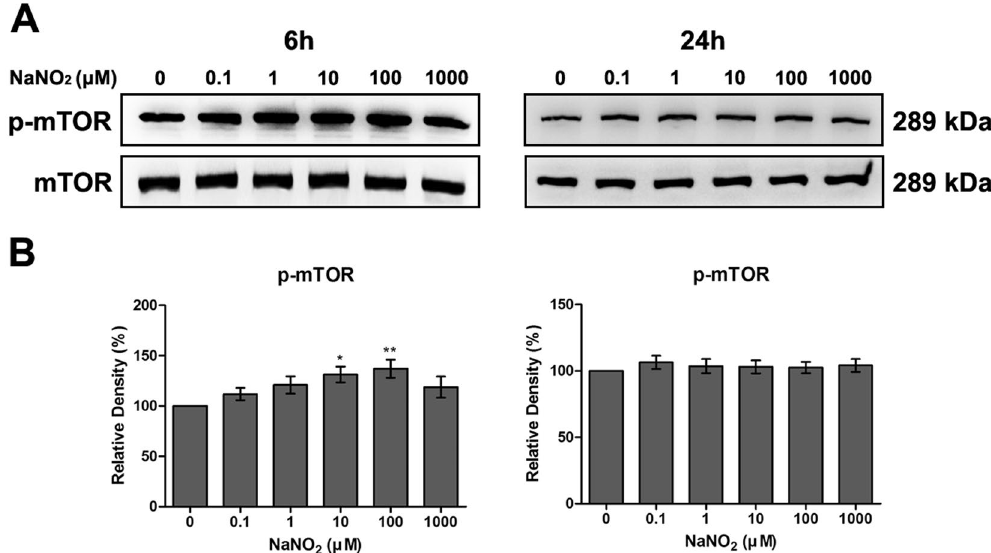
Figure 4. Effect of NO on mTOR pathway of HCEC. Expression levels of phosphorylated mTOR (p-mTOR) and mTOR, detected by western blot analysis ( A ) and relative densitometry ( B ), were calculated as a percentage of the control. Increased phosphorylation of mTOR was observed at 6 h exposure to 10 μ M and 100 μ M of NaNO 2 . Full size images of blots are available in the Supplementary information. Values are presented as mean ± SEM and were obtained from three independent experiments; each independent experiment was performed in triplicate. * p < 0.05, ** p < 0.01.